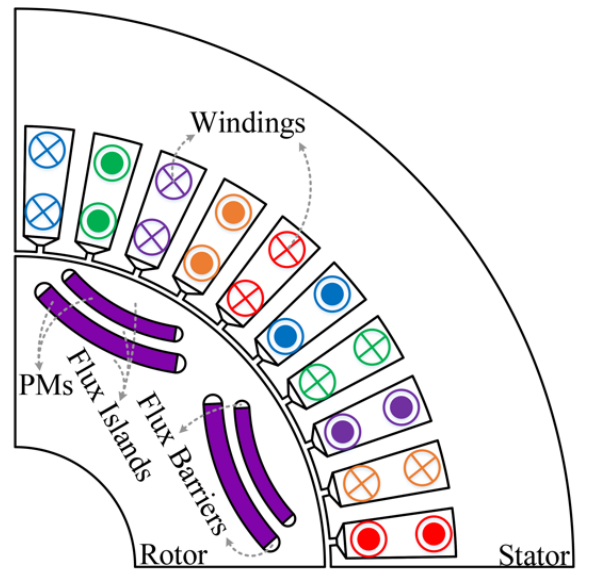
Figure 2. PMASynRM Structural Design and Winding Pattern. Table 1. Design Constrains. Figure 1. Proposed Models: ( a ) Model-I (PMASynRM), ( b ) Model-II, ( c ) Model-III, ( d ) Model-IV and ( e ) Model-V.